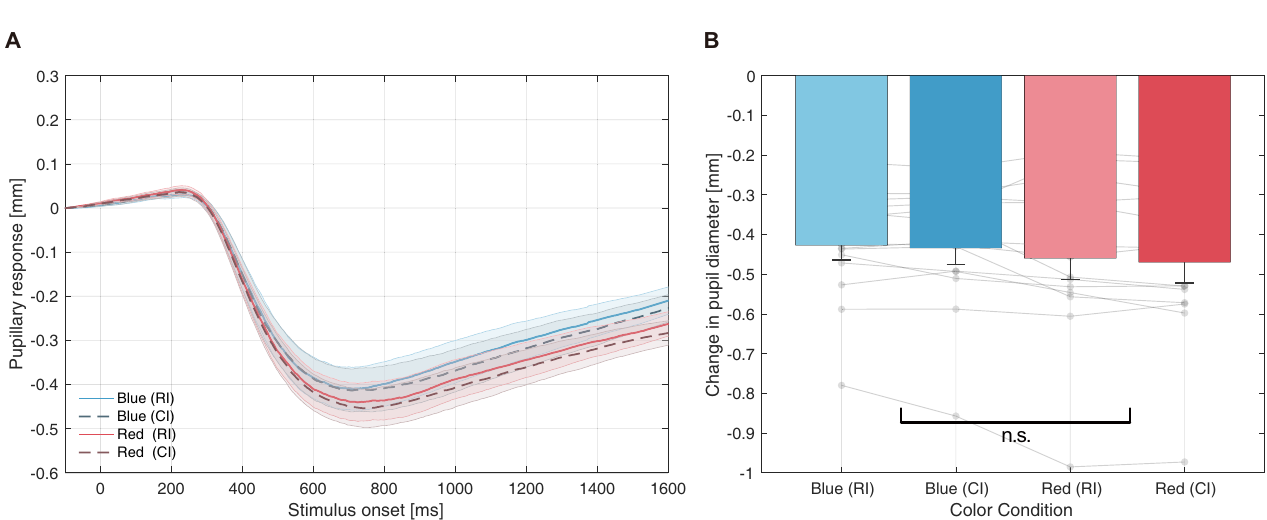
Fig 6. Pupillary response to each color stimulus (PLR-based equiluminance). (A) Mean change in pupil diameter from stimulus onset. Each line represents pupillary responses to RI and CI stimuli, whereas the shaded regions are standard mean errors. (B) Mean peak PLR amplitudes for each color condition. Peak PLR amplitude is determined as the minimum pupil diameter between 300–1,300 ms in the time domain. The overlaid semitransparent dots indicate each participant’s data. Abbreviations: CI–comparison interval, PLR–pupillary light reflex, RI–reference interval. https://doi.org/10.1371/journal.pone.0270110.g006 Duration judgment. The CI-longer probabilities for all CI durations were again used for psychometric function fitting. The PSEs for each color sequence condition (B–B, R–R, R–B, and B–R) were calculated by fitting a cumulative normal function and determining the 50% point. Fig 7 shows the mean psychometric function computed using the average of all partici- pants’ CI-longer proportions in each CI duration condition.